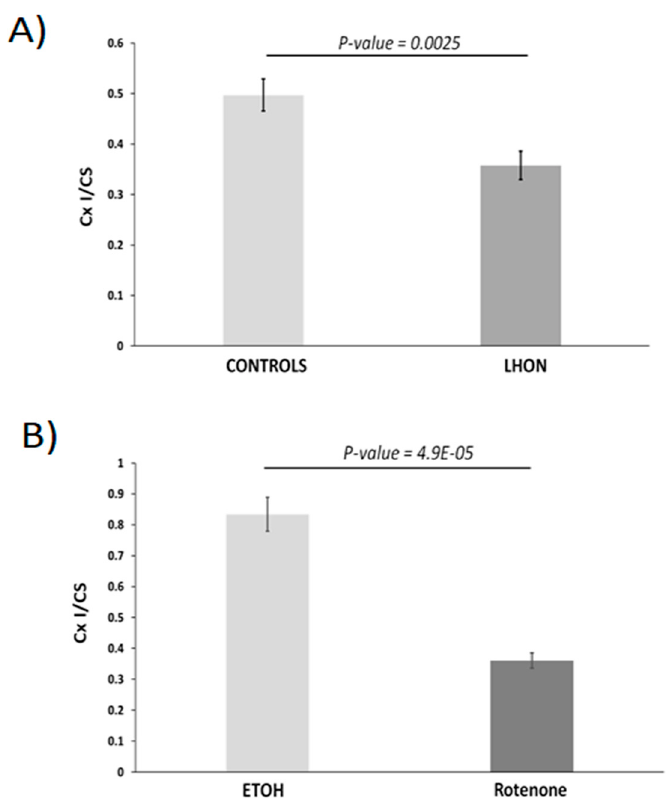
Figure 1. Enzymatic activity of Complex I (Cx I) in LHON fibroblasts and in control fibroblasts inhibited by rotenone. ( A ) Activity in fibroblasts from LHON ( n = 11 in duplicate) and controls ( n = 7 in duplicate). Compared to controls, the average Complex I enzymatic activity in LHON fibroblasts was reduced by 28% ( p = 0.0025). ( B ) Activity in control fibroblasts treated with the vehicle (ethanol, n = 6) or treated with Complex I inhibitor (rotenone 1 µ M, n = 6). Complex I inhibition was 57% ( p = 4.9 × 10 5 ) in treated cells compared to controls. Results were normalized with respect to citrate synthase (CS) activity (Cx I / CS). Statistical significance: * p < 0.05 and ** p < 0.01.